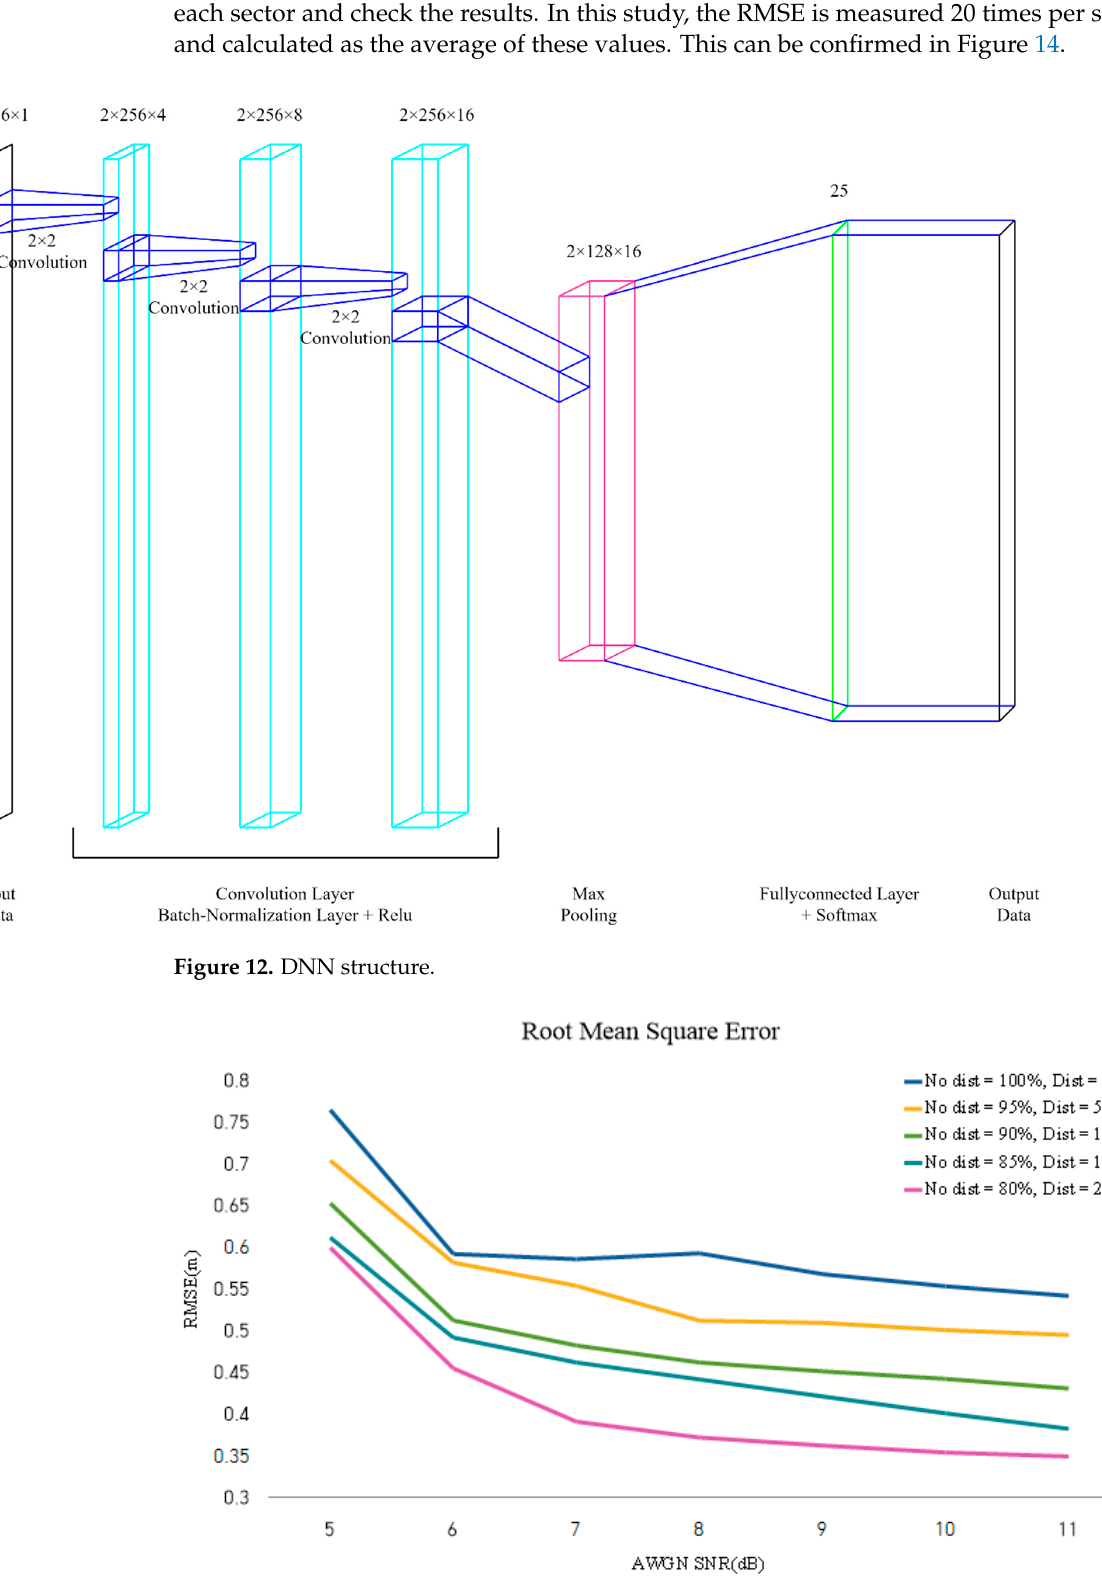
Figure 13. RMSE by AWGN SNR according to distorted data content of learning data.